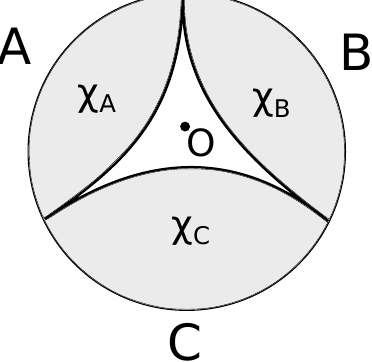
Figure 1: Bulk Cauchy slice of AdS and three boundary regions A , B , C . Gray regions are 3 the intersections of the corresponding causal wedges W and the Cauchy slice. Bulk fields C within them can be reconstructed using the respective boundaries via HKLL. Bold lines χ are the causal surfaces. For empty AdS , χ actually coincides with Ryu–Takayanagi surface. However, in general χ is larger [ 52 ] A